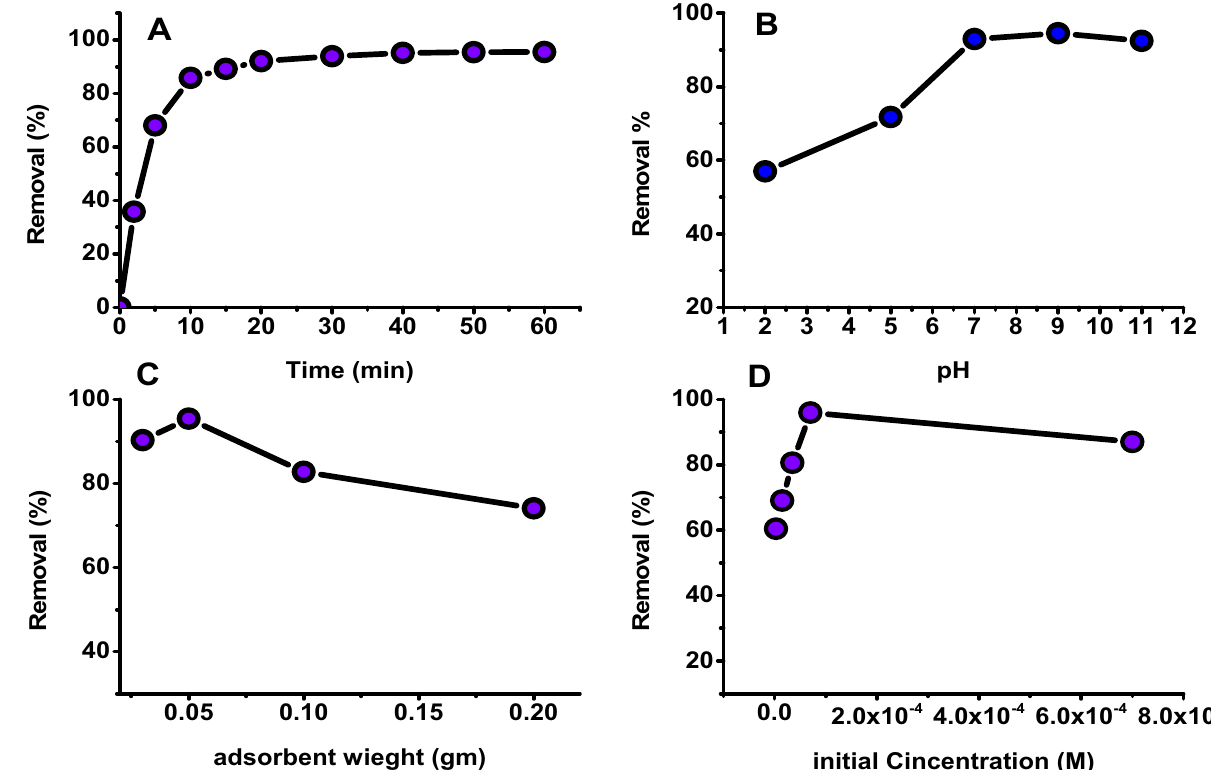
Figure 7. Effect of influential parameters on adsorption by GO- Ziziphus ( a ) contact time, ( b ) medium pH, ( c ) adsorbent weight, ( d ) initial